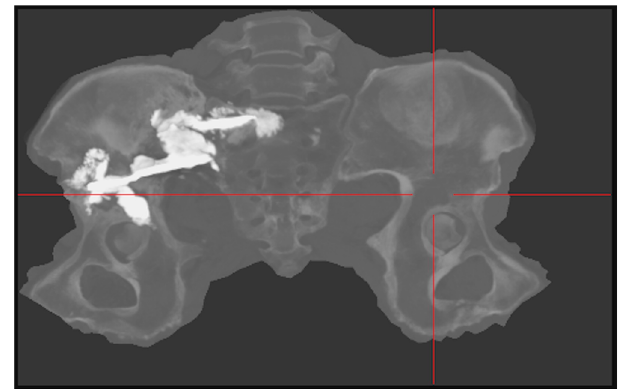
Figure 7. Postoperative CT-scan image with CT Bone Unfolding software representation showing position of the screws into the iliac and sacral bone and their bridging with